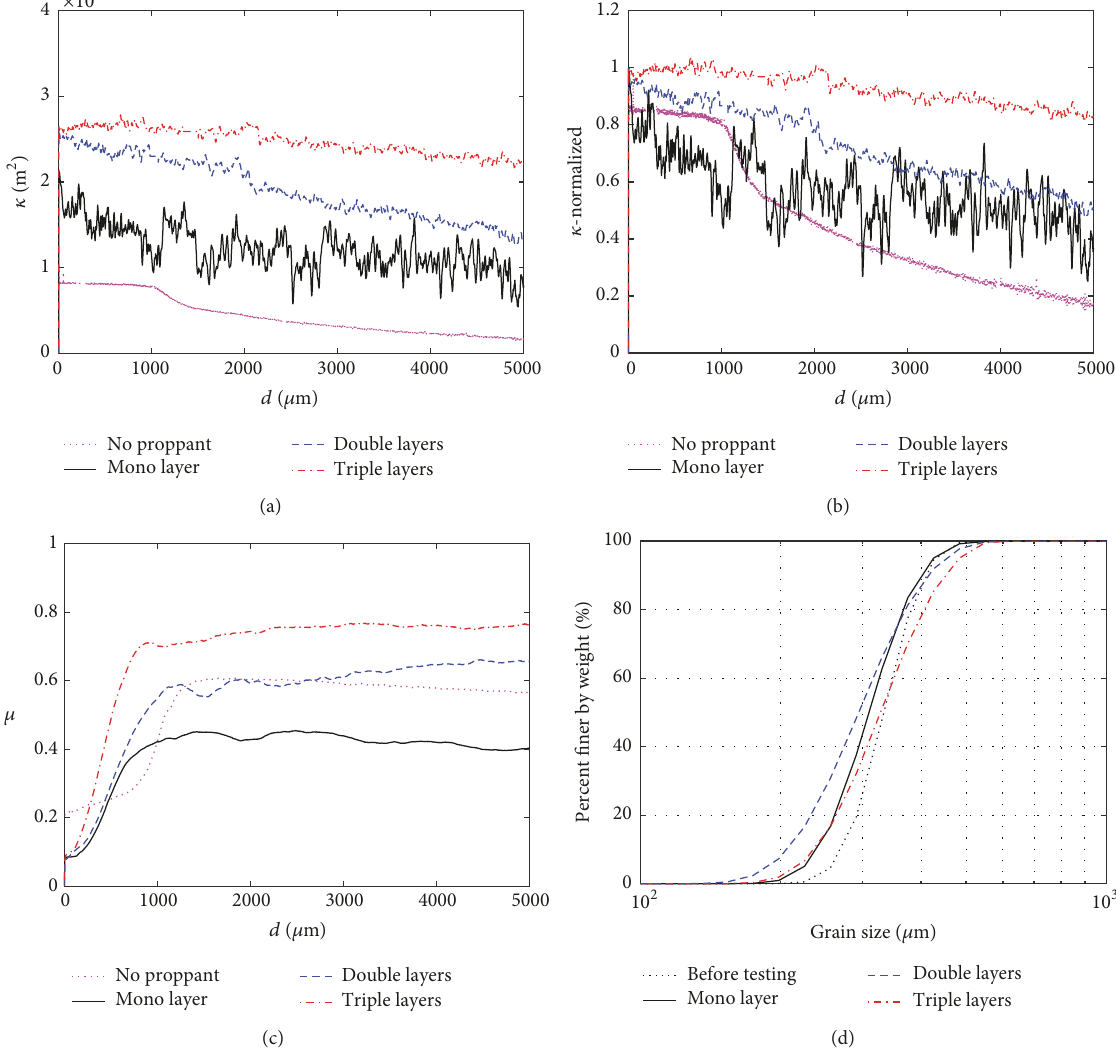
Figure 9: Evolution of (a) permeability, (b) normalized permeability (with respect to the initial permeability value), and (c) friction for the propped fracture during shearing under different proppant thickness, no proppant, monolayer, double layers, and triple layers with displacement; (d) grain size distributions of proppants before and after the experiments. The confining stress is 3 MPa and proppant size is 40/80 mesh for all